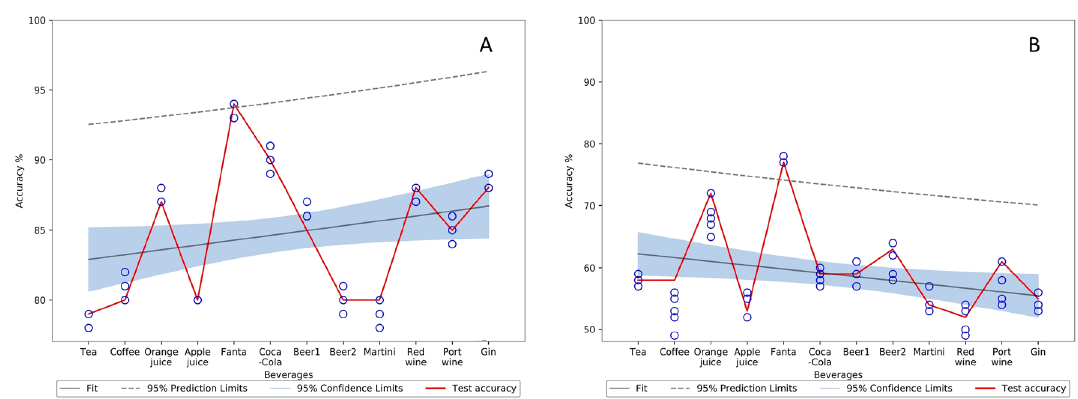
Figure 14. Paper2 confidence interval (CI) plot for beverage aging classification, ( A ) represents CI for SVM only and ( B ) represents CI for SVM with